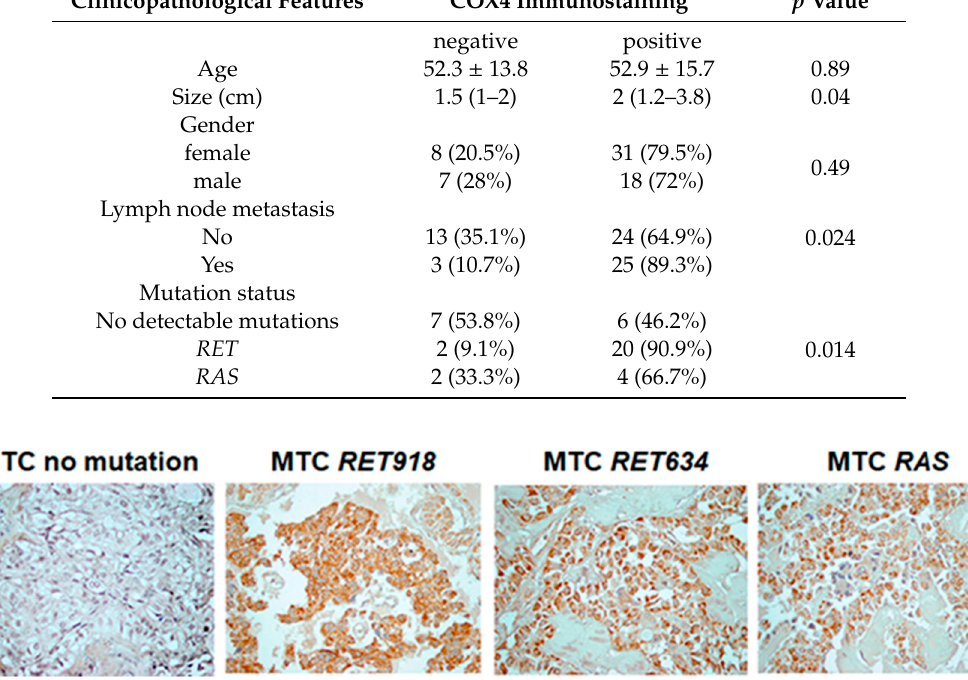
Table 2. Analysis of COX4 expression in function of clinicopathological features in patients with medullary thyroid carcinomas.